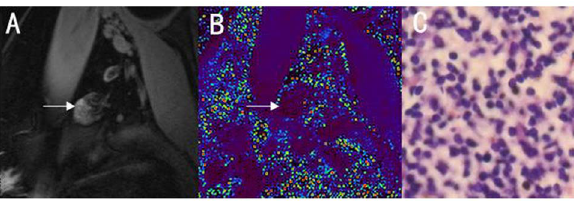
Figure 4. Benign lymph node in a 43-year-old woman. A: T2*WI, B: T2* map, with black representing the lowest T2* value and red representing the highest T2* value. C: corresponding histology image. The benign lymph node displays lower signal intensity than back- ground on the T2* map.